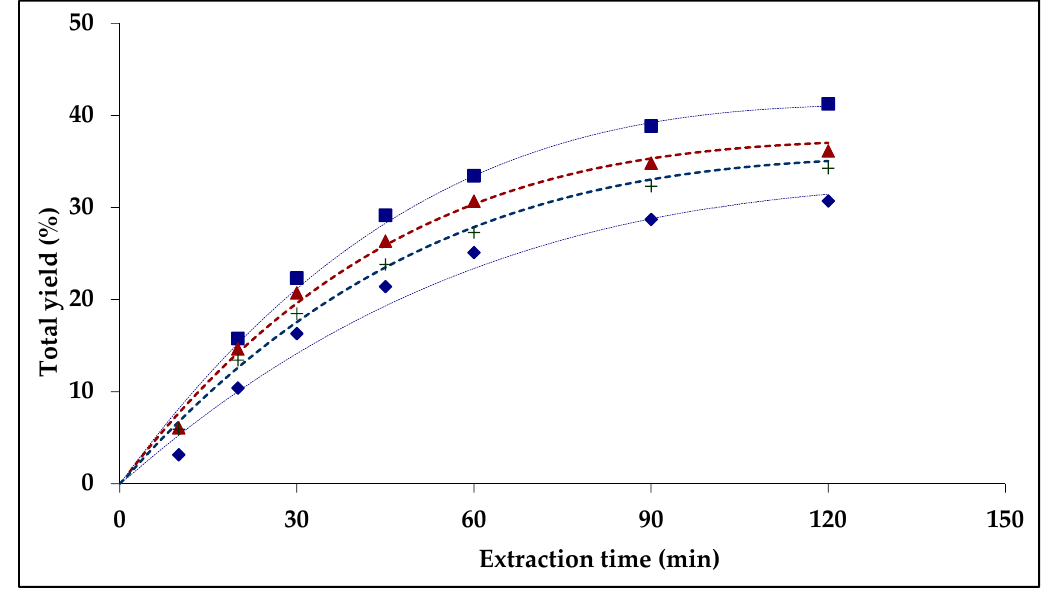
Figure 7. Comparison of experimental data with calculated curves at 35 kg h − 1 kg − 1 . ( ♦ ) 300 bar, 45 ◦ C; (+) 300 bar, 55 ◦ C ( (cid:78) ) 300 bar, 65 ◦ C; ( (cid:4) ) 400 bar, 65 ◦ C; (.....) VTII